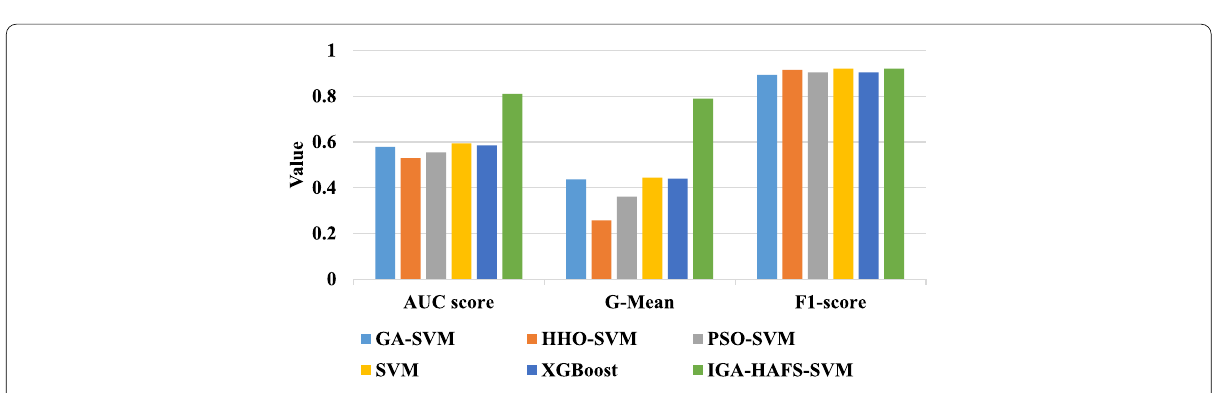
Figure 9 Comparison of wafer quality prediction